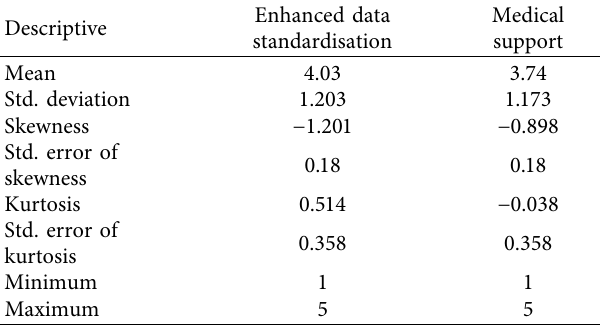
Table 1: descriptive statistics.